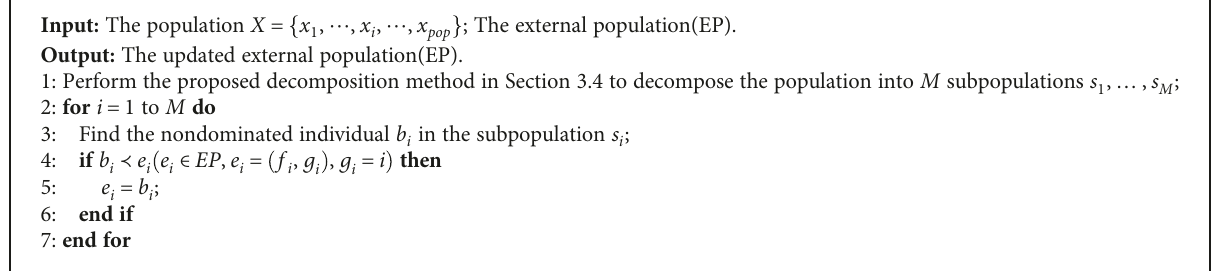
Algorithm 3: Nondominated solution selection.